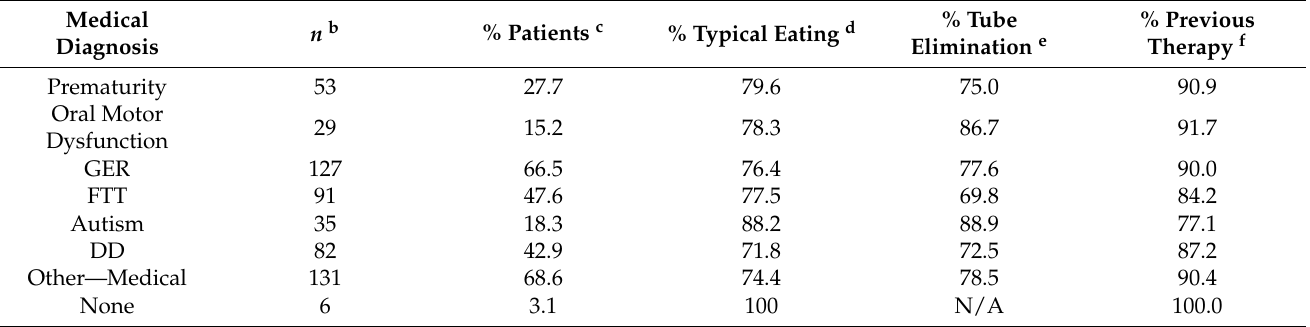
Table 1. Categorization by Medical Diagnosis ( n = 191) a .